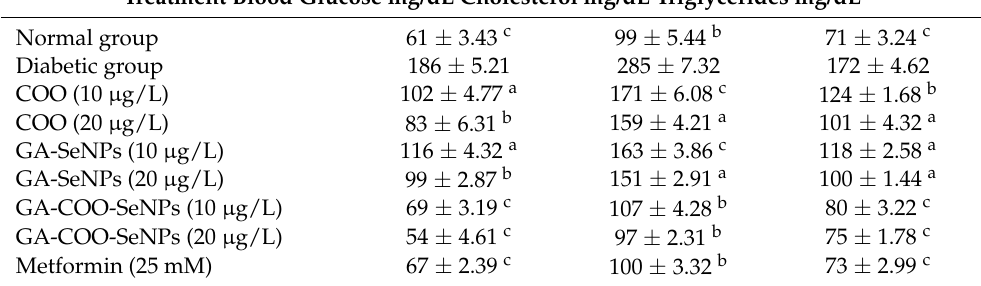
Table 2. Effects of COO extract, SeNPs, and GA-COO-SeNPs on serum profiles of blood glucose, cholesterol, and triglyceride levels in adult